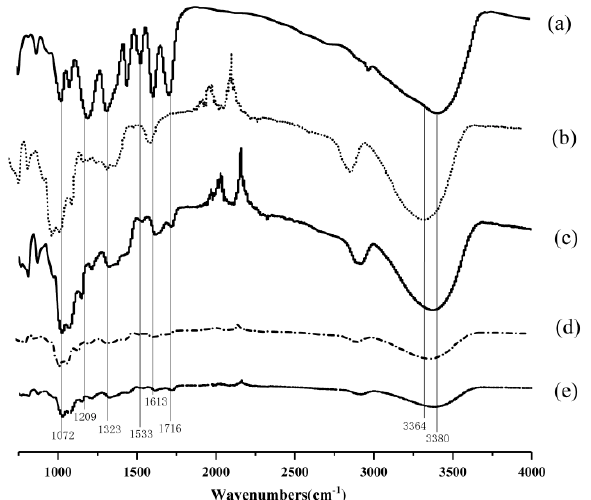
Figure 5. FT-IR spectra of the: TA powder (a); neat GG (b); and of GG fibrous mats loaded with: 10% TA (c); 15% TA (d); and 20% TA (e).